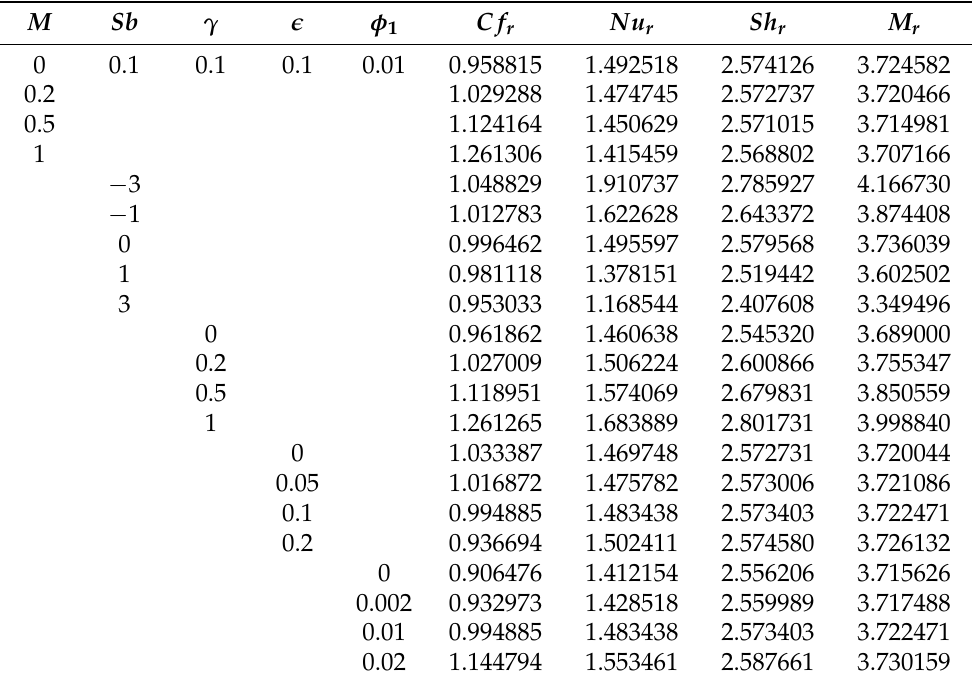
Table 5. Variations in quantities of interest with magnetic field, Stefan blowing, curvature, free stream and initial nanoparticle volume fraction parameters.